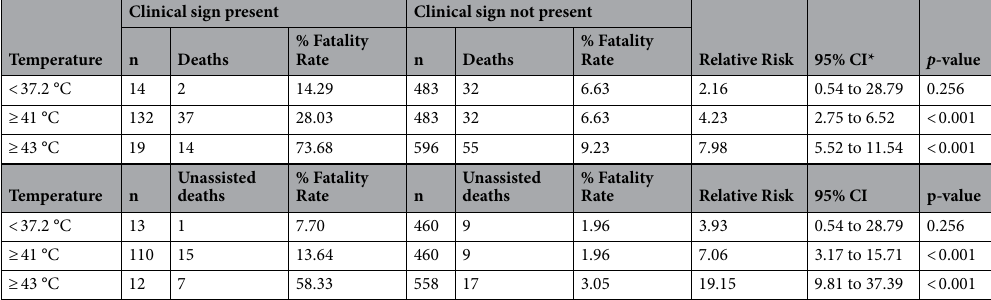
Table 4. Body temperature at veterinary presentation as a risk factor for death (all causes) and unassisted death in dogs diagnosed with heat-related illness presenting to primary-care veterinary practices in the UK between 2016 and 2018. Relative risk describes the risk of death in heat-related illness cases meeting each temperature criterion compared to cases that did not meet this criterion. *CI confidence interval n = 629 for overall death analysis, n = 583 for unassisted death